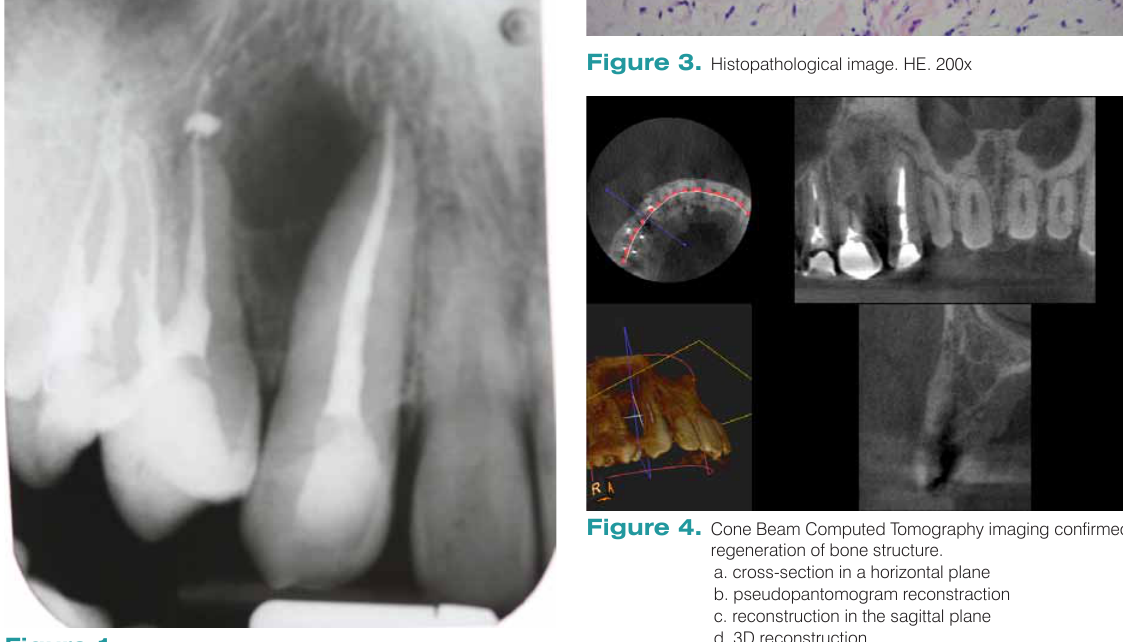
Figure 1. X-ray of patient PM